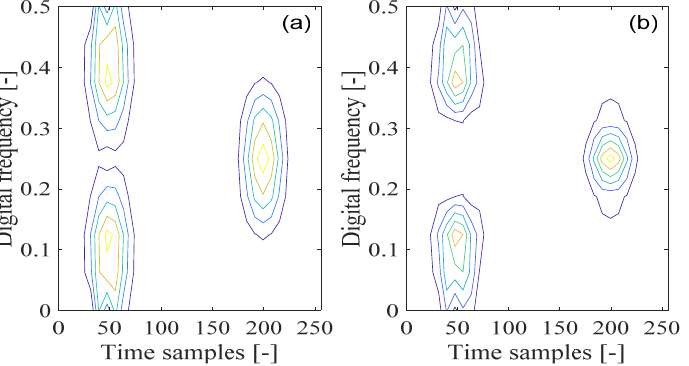
Figure 2. The spectrogram of nonstationary signal composed of three transient Gaussian components; ( a ) Chebyshev window; ( b ) Kaiser window.